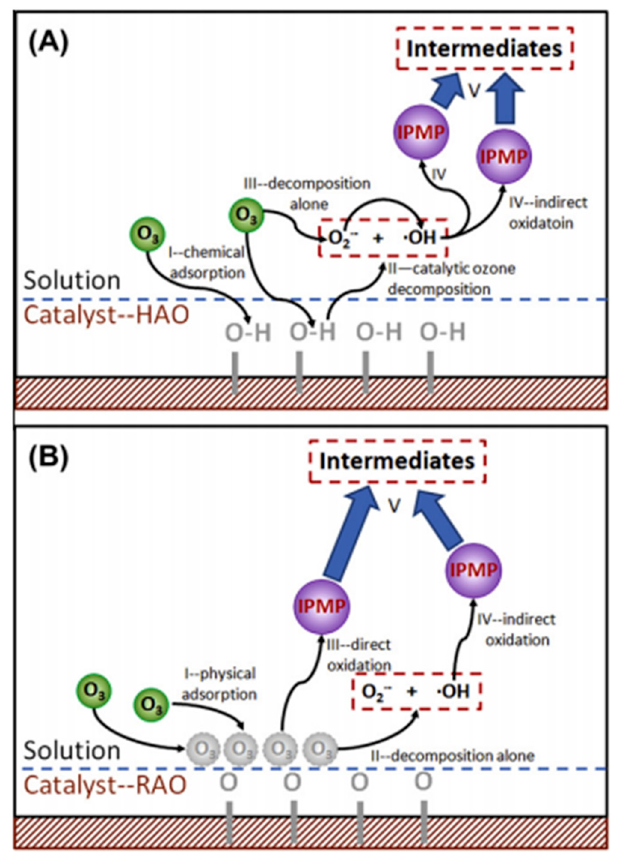
Figure 6. Proposed reaction pathway in catalytic ozonation by γ -AlOOH ( A ) or γ -Al 2 O 3 ( B ).